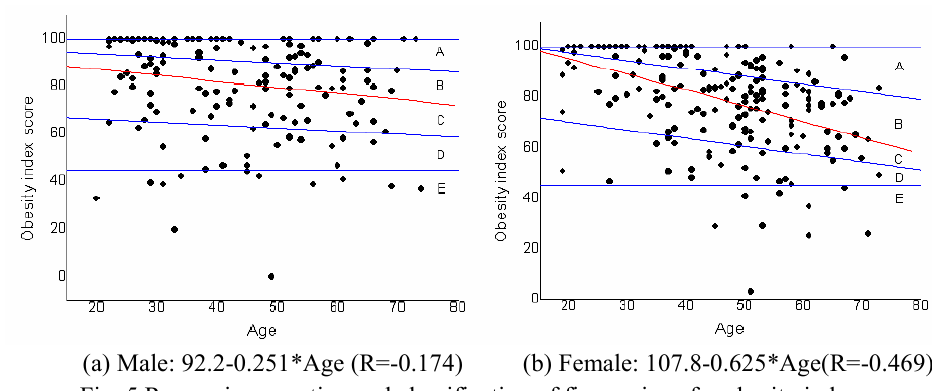
Fig. 5 Regression equation and classification of five regions for obesity